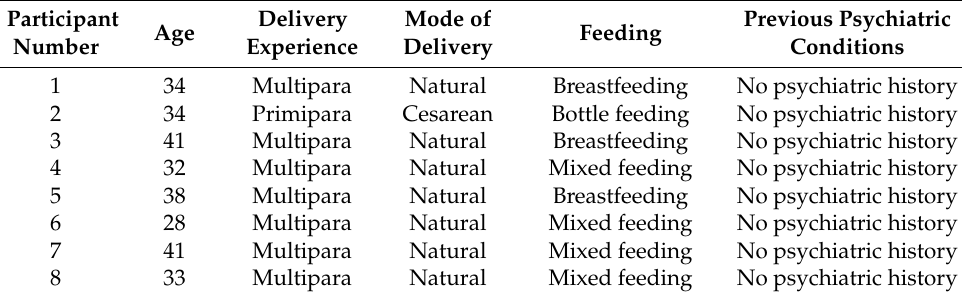
Table 1. General characteristics of the